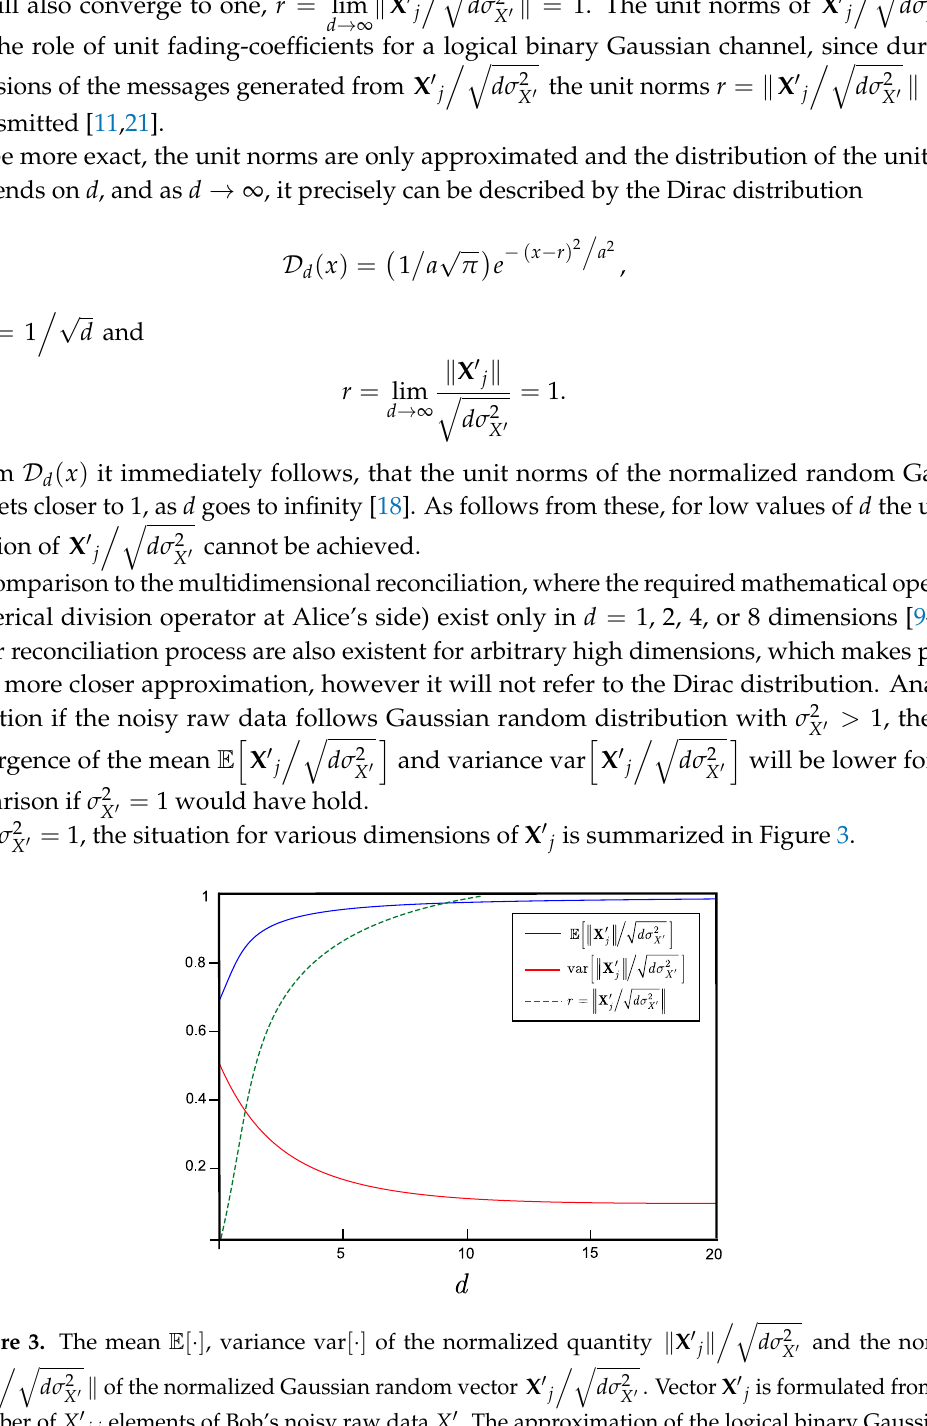
(cid:46)(cid:113) d σ 2 and the norm X (cid:48) (cid:46)(cid:113) d σ 2 . Vector X (cid:48) j is formulated from d j X (cid:48)